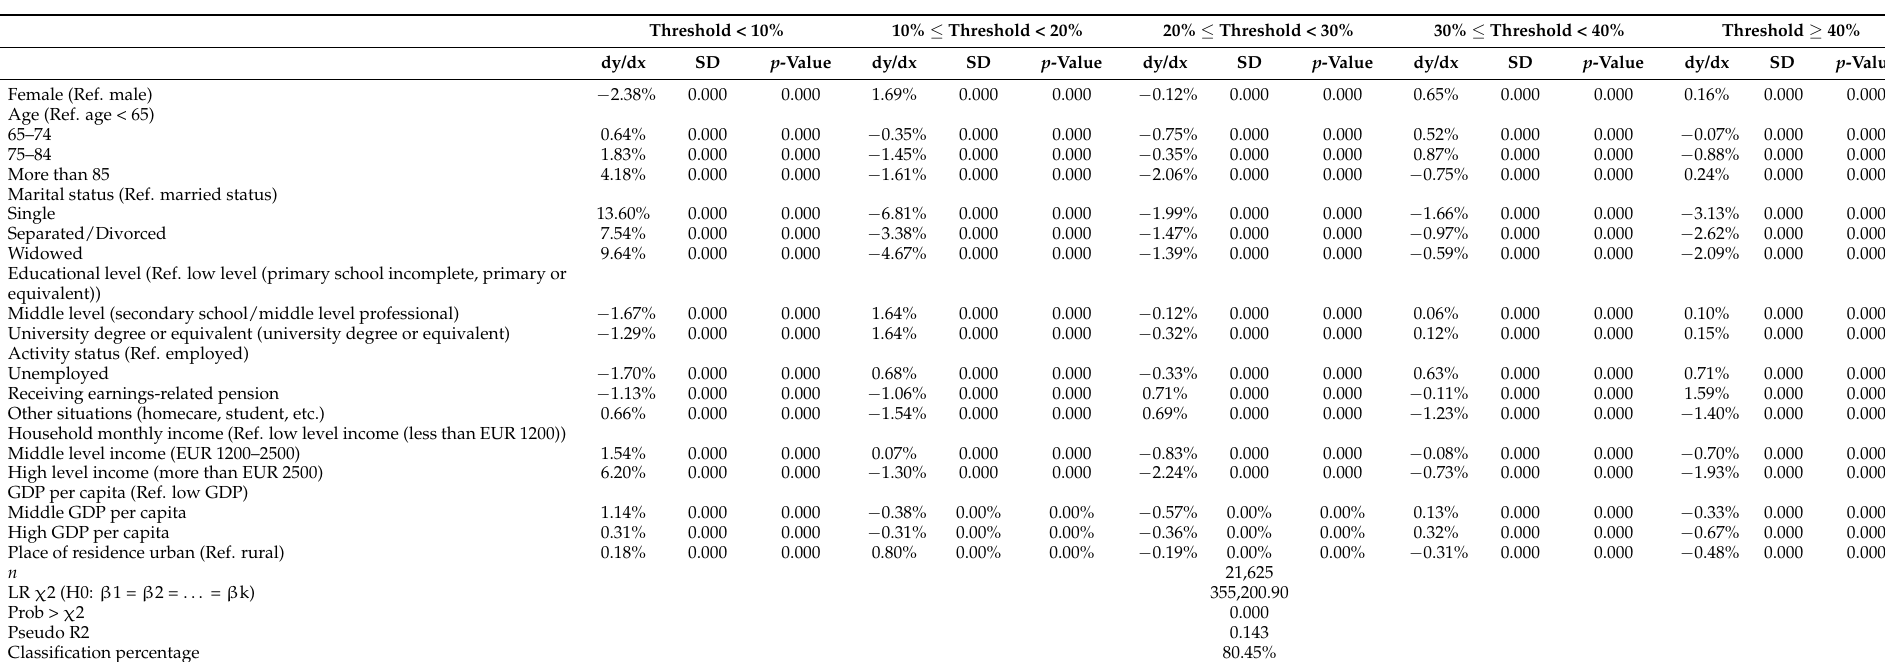
Table 6. Marginal effects of the sociodemographic factors of households in Spain associated with financial catastrophism derived from out-of-pocket payments in health in Spain. Year